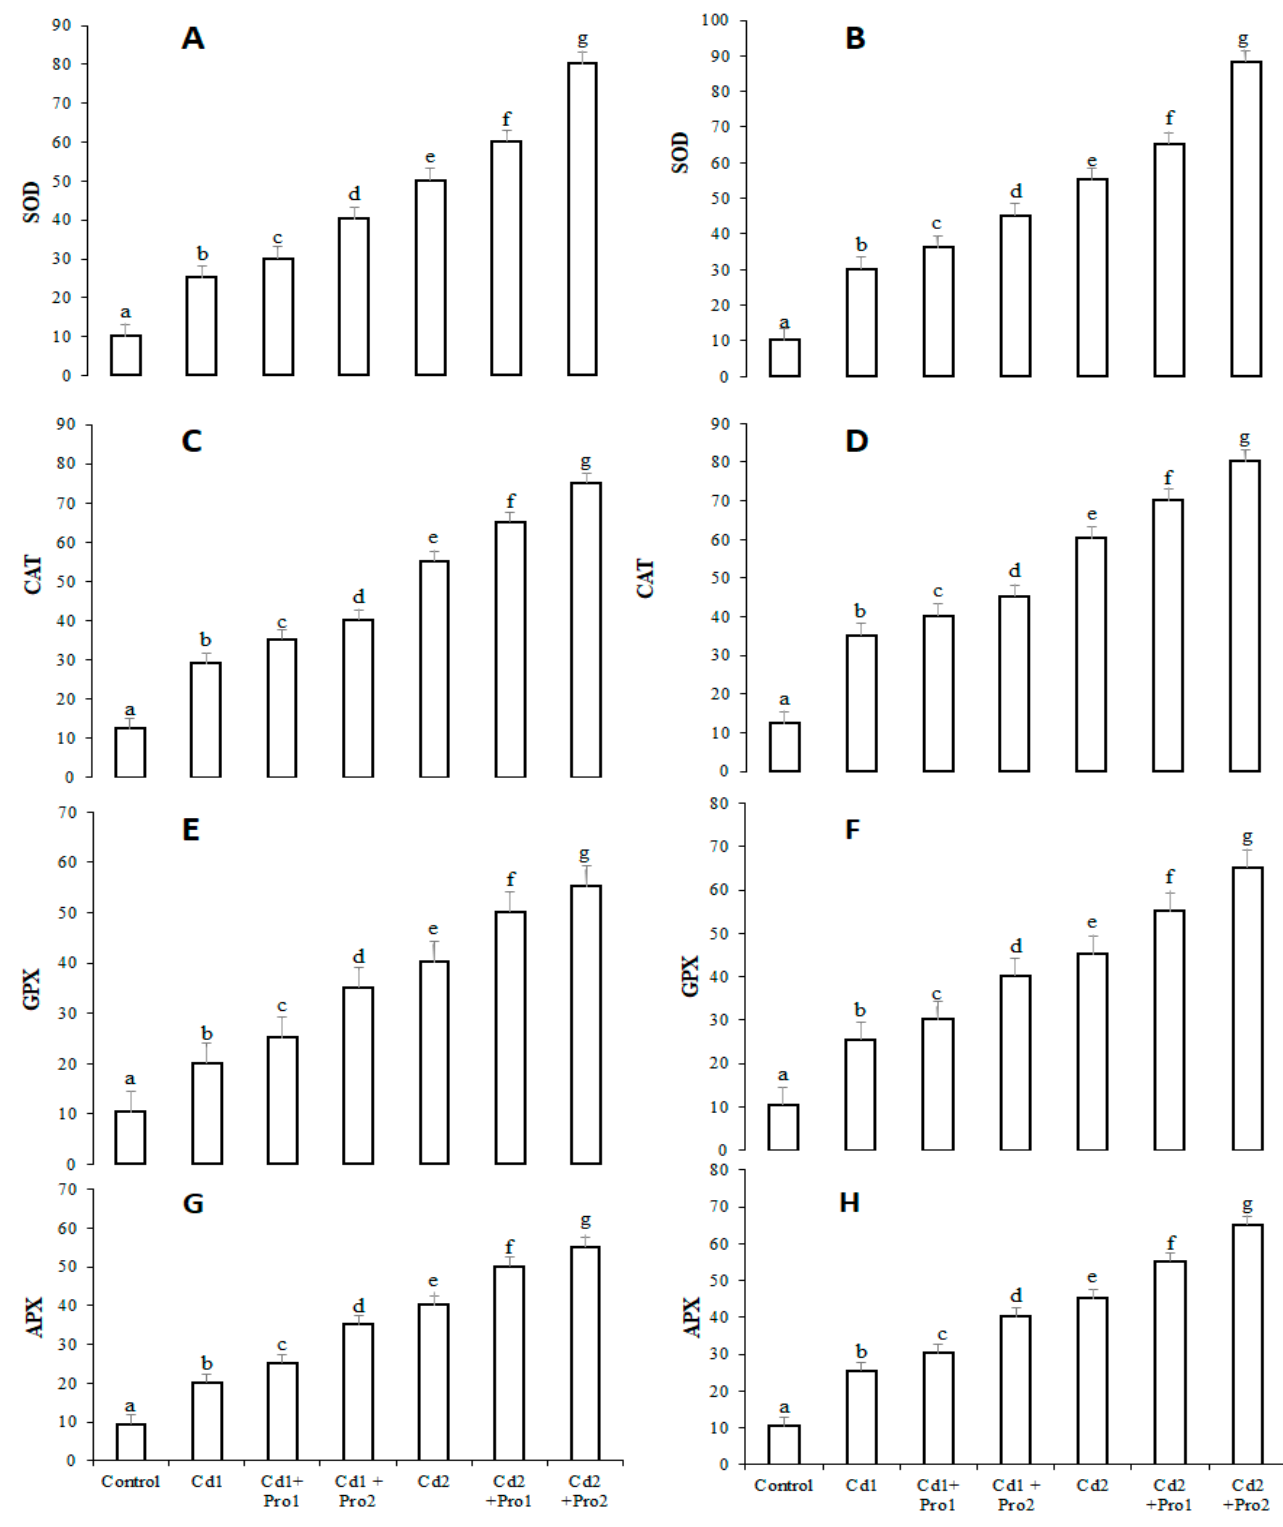
Figure 3. Superoxide dismutase (SOD) activity (U mg − 1 protein), peroxide reductase catalase (CAT) activity (U mg − 1 protein), glutathione peroxidase (GPX) activity (U mg − 1 protein), and ascorbate peroxidase (APX) activity (U mg − 1 protein) in leaves ( A , C , E , G ) and roots ( B , D , F , H ) of pigeon pea plants subjected to various cadmium and exogenous proline treatments. Bars represent the mean of three replicates ± SD. Cd 1 (4 mg), Cd 2 (8 mg), Cd 1 + Pro 1 (4 mg Cd + 3 mM proline), Cd 1 + Pro2 (4 mg Cd + 6 mM proline), Cd 2 + Pro1 (8 mg Cd + 3 mM proline), Cd 2 + Pro 2 (8 mg Cd + 6 mM proline). Different small letters show significant differences ( p ≤ 0.05) according to Duncan’s multiple range test.